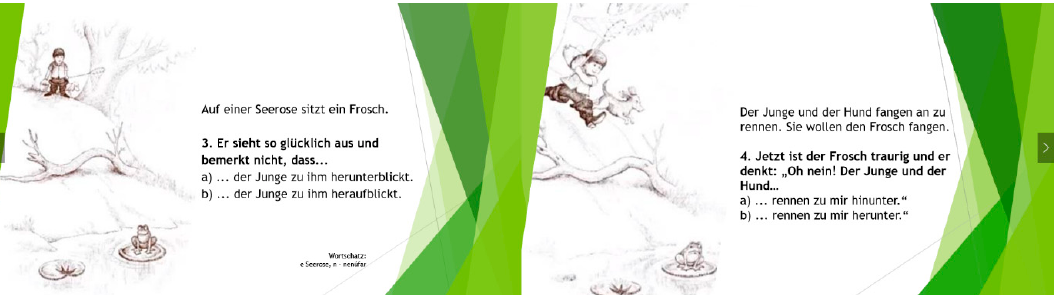
Figure A15. Pretest: Binary-choice recognition task.